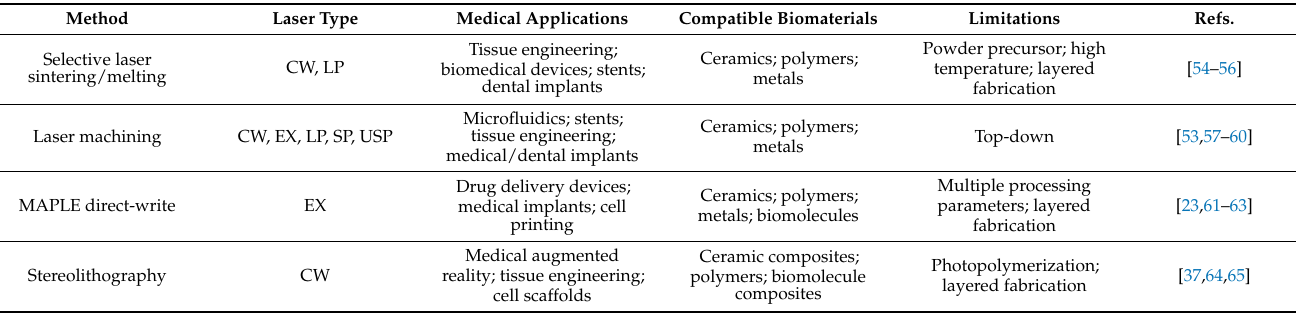
Table 2. Laser-based direct-write